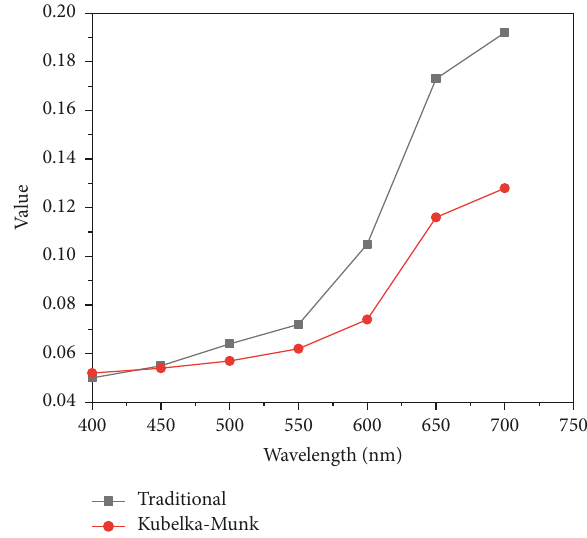
Figure 4: Fitting formula color error comparison chart (blue silk).